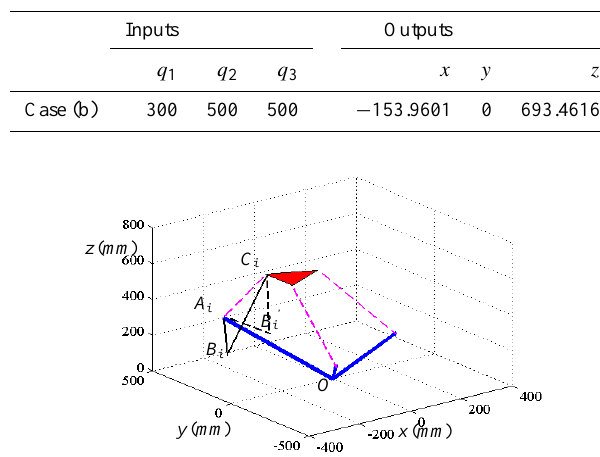
Table 2. Forward position analysis of the mechanism (unit: mm).